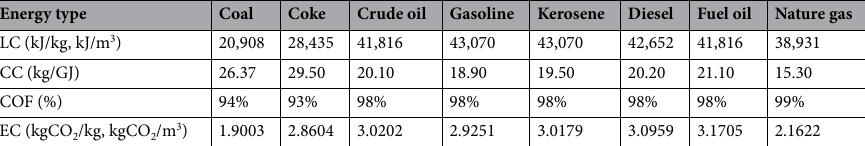
Table 3. Carbon emission coefficients of various types of